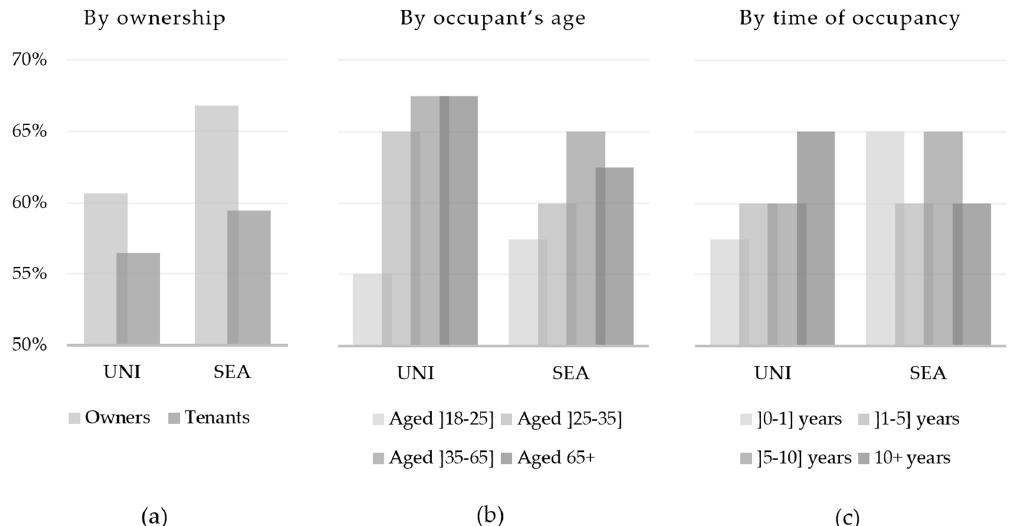
Figure 5. Data for the OEI: ( a ) By ownership; ( b ) By occupant’s age; ( c ) By time of occupancy.